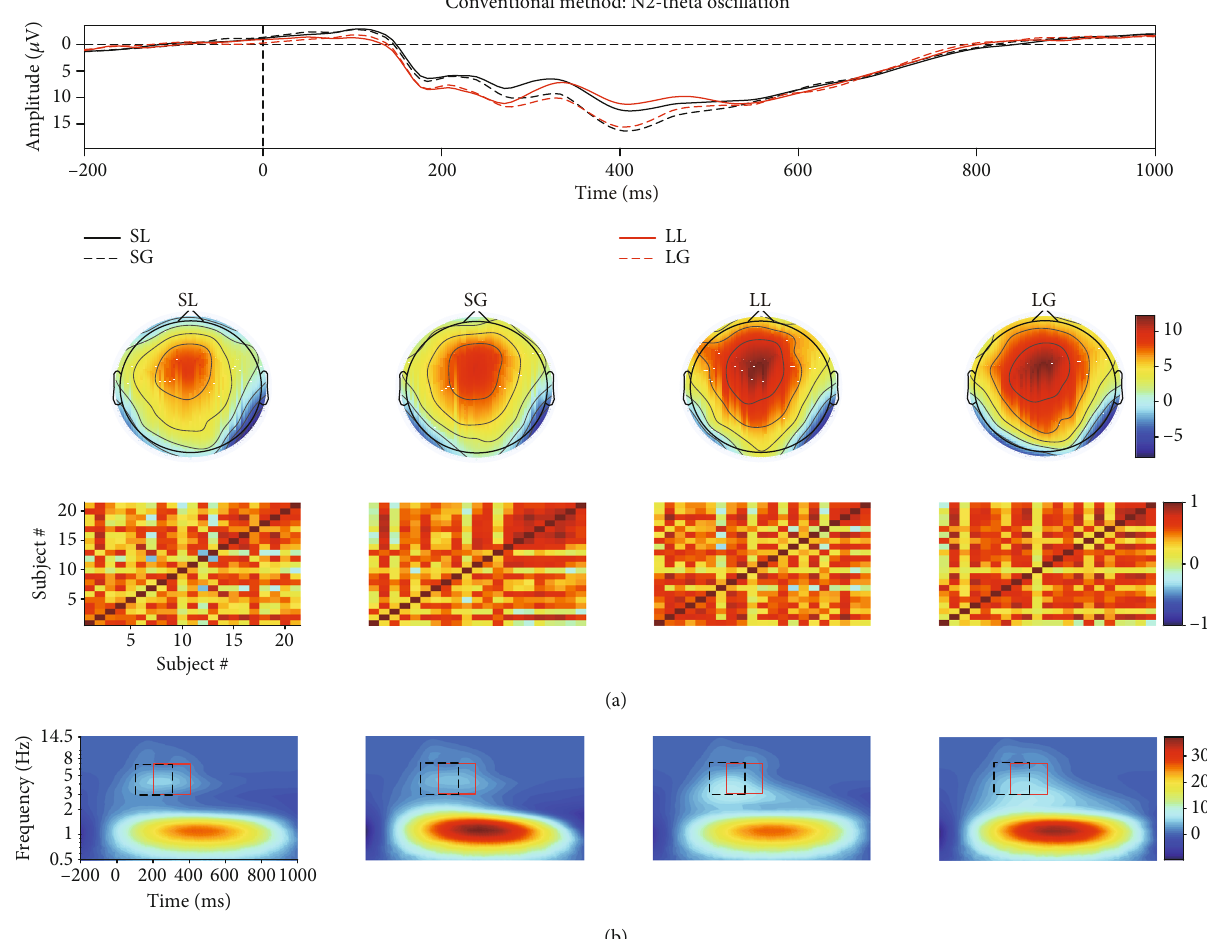
Figure 6: (a) The grand averaged waveform (at Fz, FCz, and Cz electrodes), topography (time window: 180-240 ms), and similarity of topographies across participants of each condition for the fi ltered real signal. (b) The associated grand averaged time-frequency representation (TFR) of every condition. The region of evoked ERO of each condition is determined by the edge detection algorithm and the conventional rectangle method (for the black dotted rectangle, the time window is 100-300 ms and frequency range is 3-7 Hz, “ R1 ” ; the red solid rectangle: 200-400 ms and 3-7 Hz, “ R2 ” ) separately. SL: loss condition under short waiting time; SG: gain condition